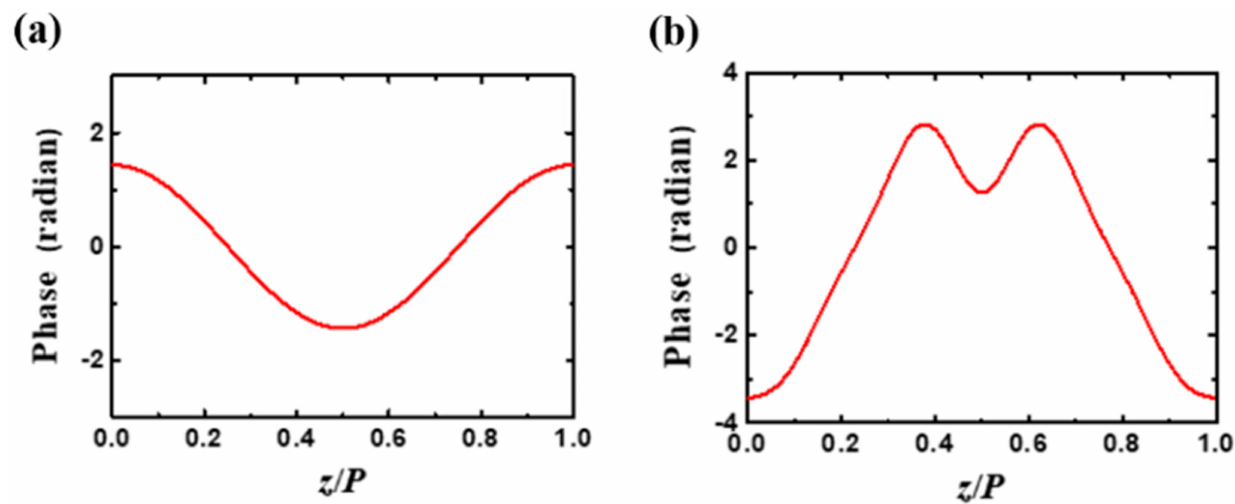
Figure 33. Optimized results for phase distribution of the phase-only sampling function: ( a ) 3-channel and ( b ) 9-channel. Adapted with permission from ref. [175]. © The Optical